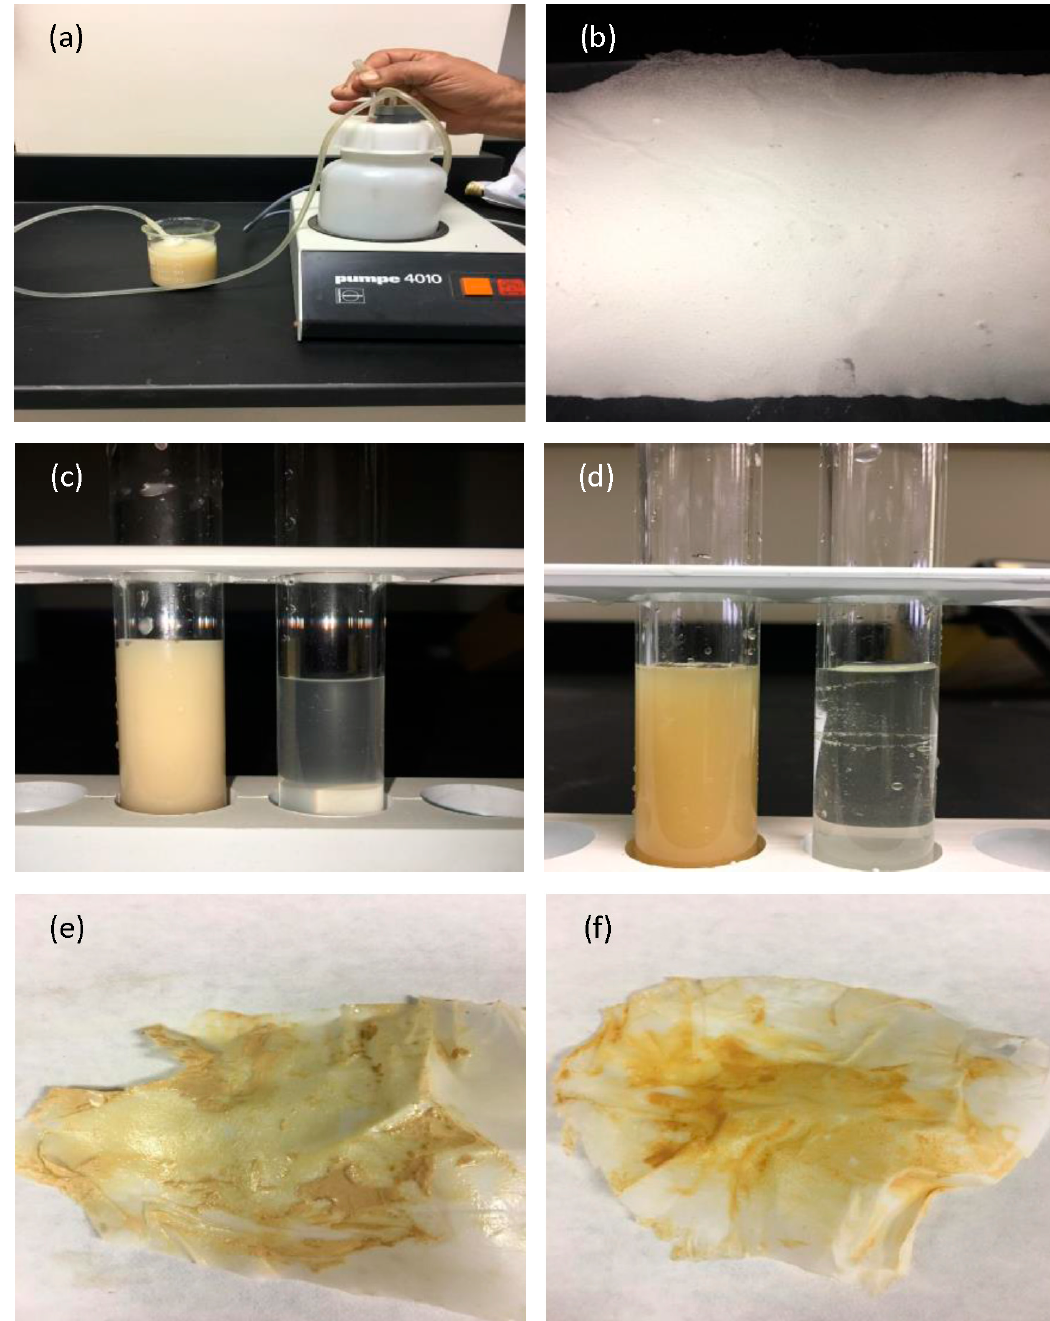
Figure 7. Wastewater treatment processes. ( a ) Pump with unprocessed wastewater; ( b ) The surface of the membrane before the filtration process; ( c ) Direct filtration by the nanofiber membrane from wastewater with very small clays in the Saudi soil; ( d ) Direct filtration by the nanofiber membrane from wastewater with sand from the Saudi Earth; ( e ) Particles at the surface of the membrane after the filtration process from clays; and ( f ) Particles at the surface of the membrane after the filtration process from very small sand.